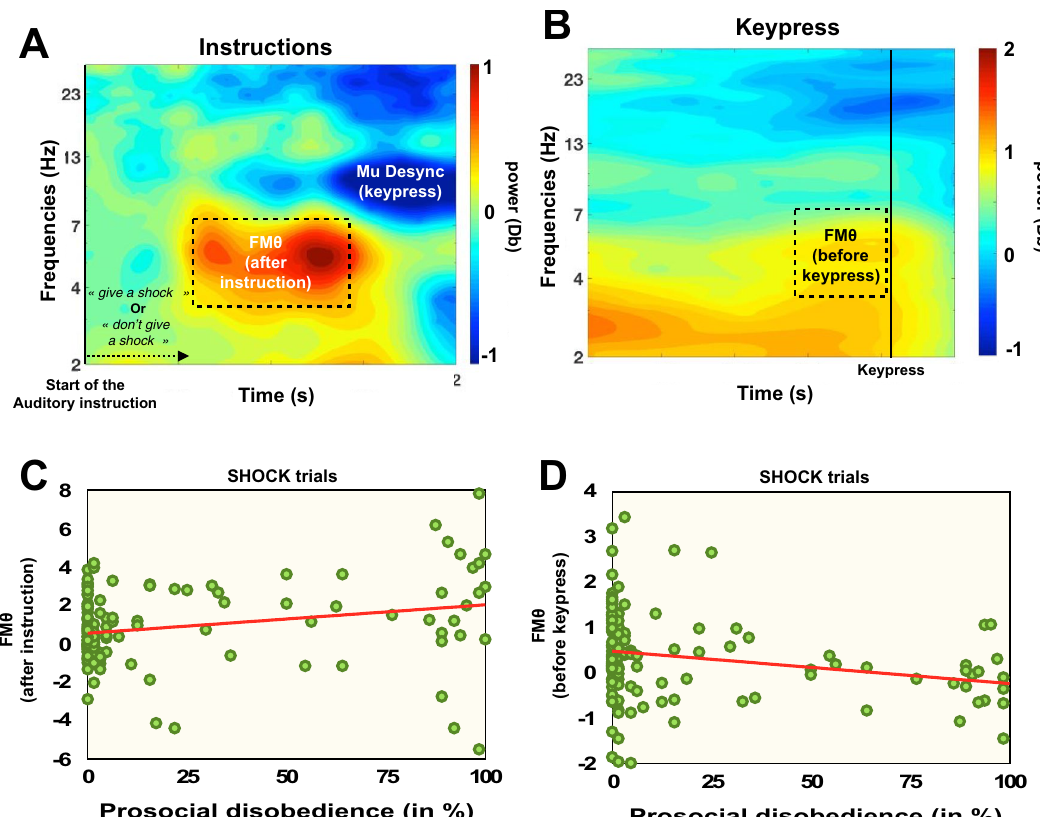
Figure 3. Time frequency power plots for the 4 electrodes (Fz, Cz, FC1, FC2) after hearing the instructions ( A ) and before pressing the key to obey the orders of the experimenter ( B ). Mu D represents the desynchronization in the Mu band (8-12 Hz), which is typical of movement execution (i.e., keypress). ( C ) Graphical correlation of the positive correlation between FMθ after the instruction to send a shock to the victim and prosocial disobedience. ( D ) Graphical correlation of the negative correlation between FMθ before the keypress associated with sending a shock to the victim and prosocial disobedience. All tests were